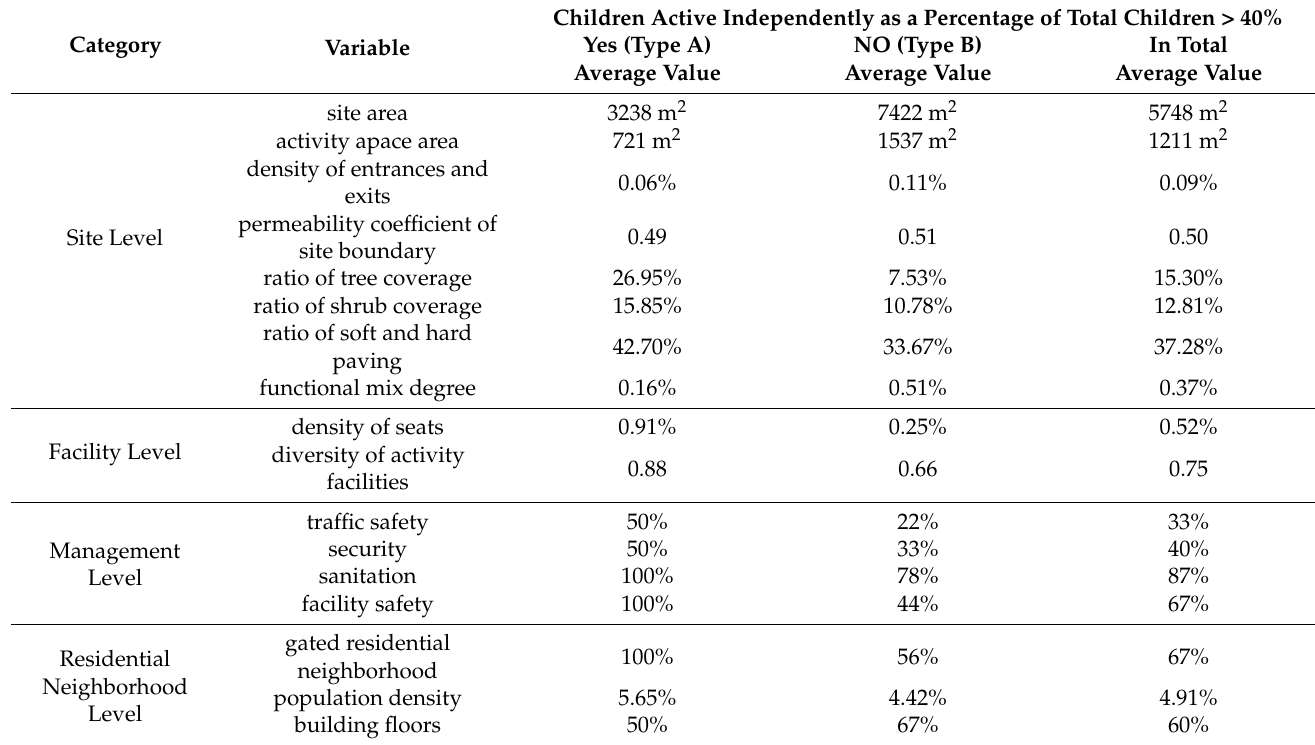
Table 6. Built environment and proportion of CIAs in sample residential